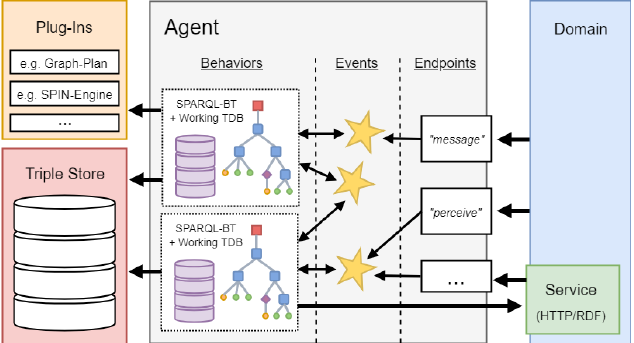
Figure 10. Schematic structure of the agent model [25].